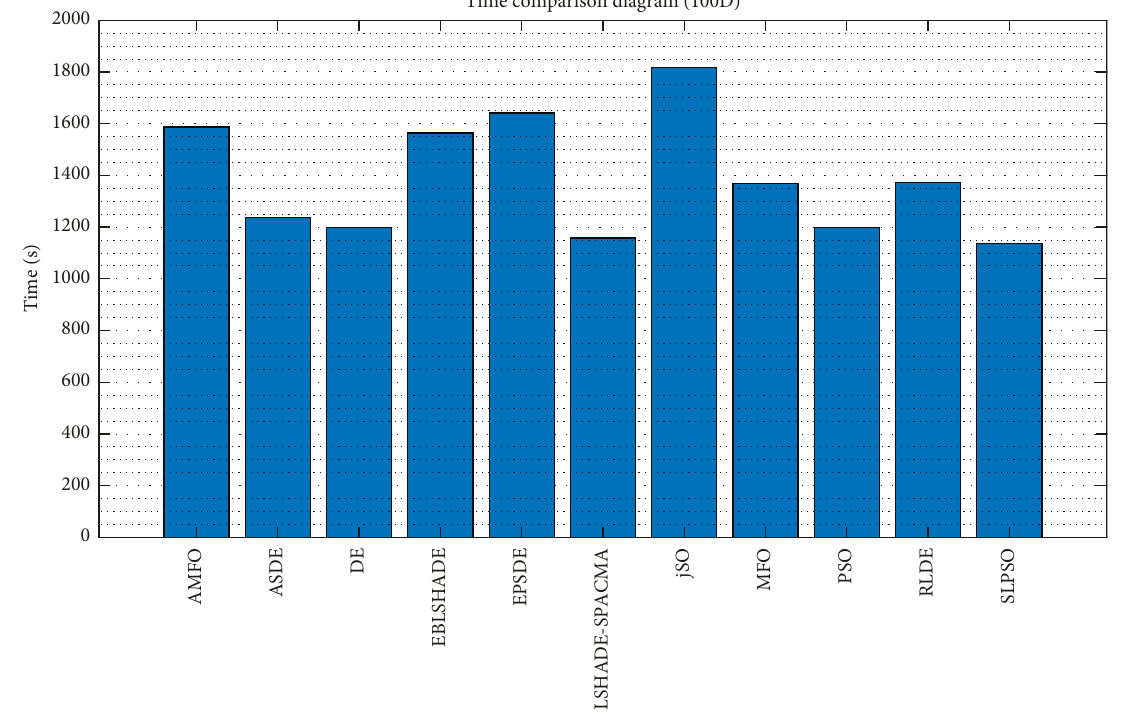
Figure 5: Mean CPU time of 11